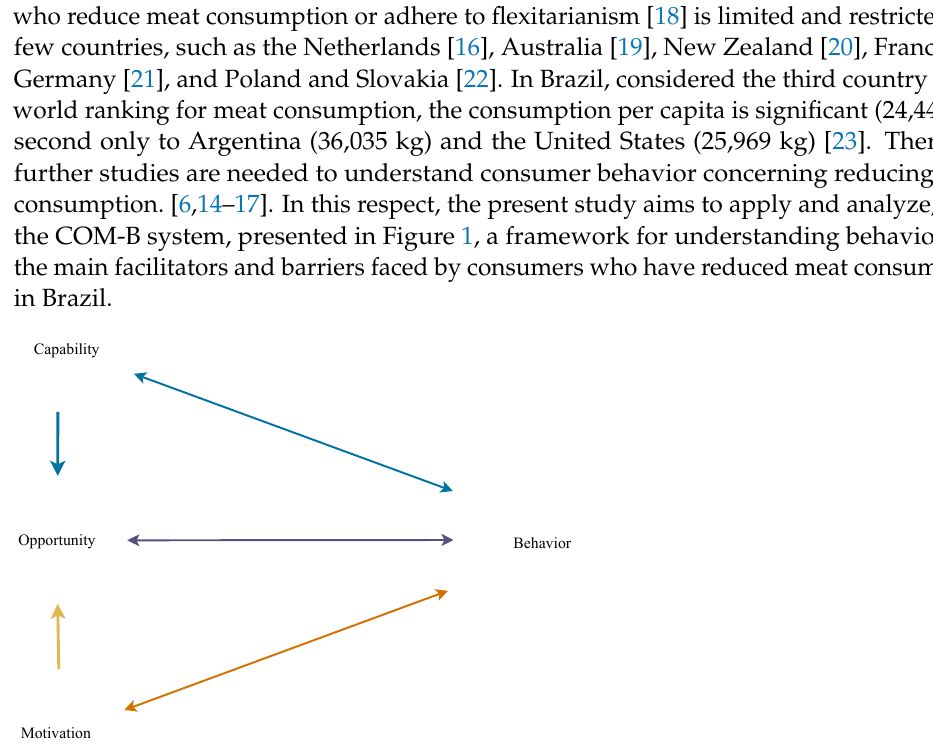
Figure 1. The COM-B system. Source: adapted from Michie et al. [24] (p. 4). Note: The arrows represent the potential influence between the proposed elements .